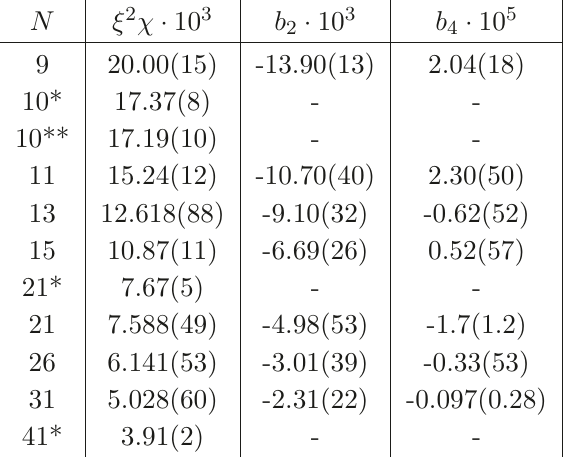
- Table 2 . In this table we report continuum extrapolated results for different values of N . We report also some results obtained in other recent studies. In particular, results marked by * and ** are taken from refs. [19] and [51], respectively; in these works only ξ 2 χ is